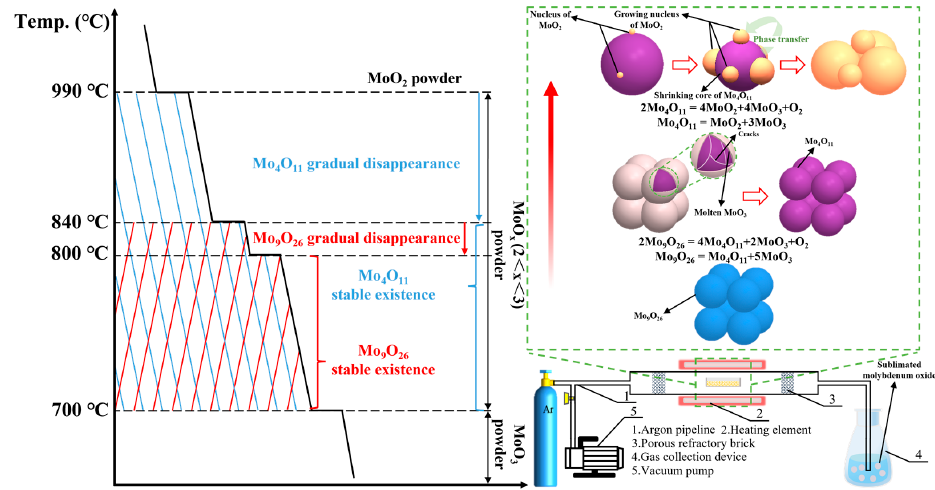
Figure 9. Thermal stability and decomposition mechanism of substoichiometric molybdenum oxides.